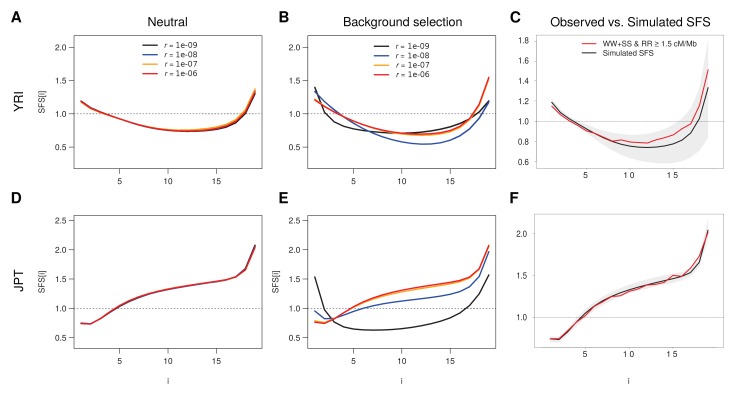
Simulated SFS under neutrality and with background selection for various recombination rates.Individual based simulations under demographic parameters inferred from neutral sites (WW + SS sites with r ≥ 1.5 cM/Mb) as reported in Supplementary file 3 - Table S3 were done for the Yoruba (YRI) and Japan (JPT) populations. (A, B) Unfolded SFS based on the YRI demographic parameters without (A) and with (B) BGS. (D, E) Unfolded SFS based on the JPT demographic parameters without (D) and with (E) BGS. Shaded areas delimit a 95% range obtained from 100 simulations. A recombination rate of r = 10–8 corresponds here to 1 cM/Mb. See Materials and methods for details of simulations. (C, F) Comparisons between the simulated unfolded neutral SFS with r = 10−6 and the observed neutral SFS (WW + SS sites with r ≥ 1.5 cM/Mb) for YRI (C) and JPT (F).